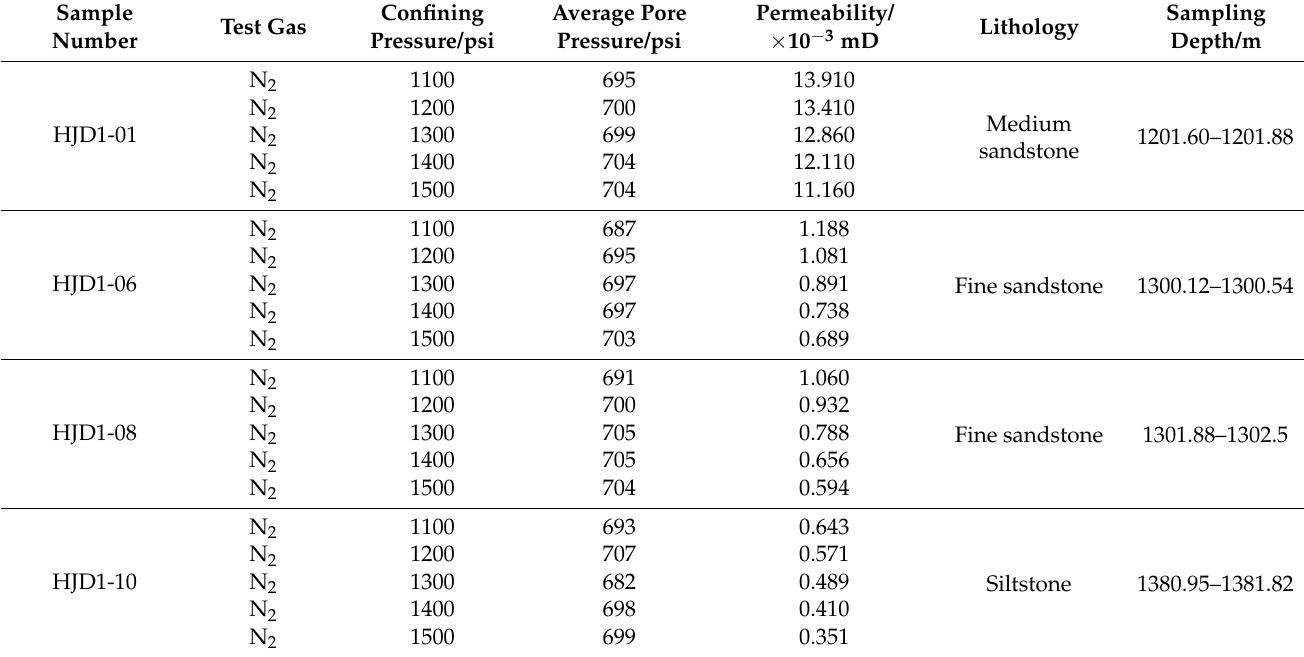
Table 2. Permeability